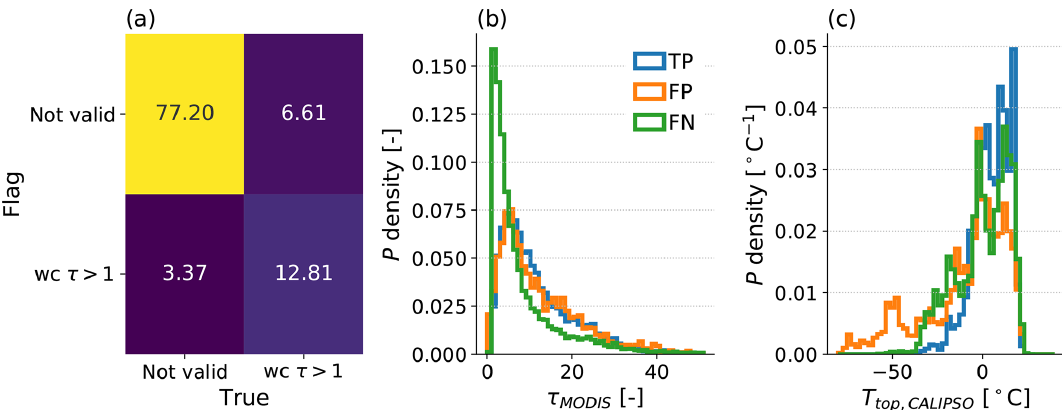
Figure 3. (a) Confusion matrix with values as a percentage, comparing trained classifiers (“flag”) with collocated MODIS–CALIPSO def- initions (“truth”) and entries being classified as a single-layer water cloud (wc) with τ > 1 or “not valid”. (b) Normalised histograms of collocated MODIS τ , where retrieved, for true positives (TPs), false positives (FPs) and false negatives (FNs). (c) Normalised histograms of collocated CALIPSO T top , where retrieved, with colours as in (b)